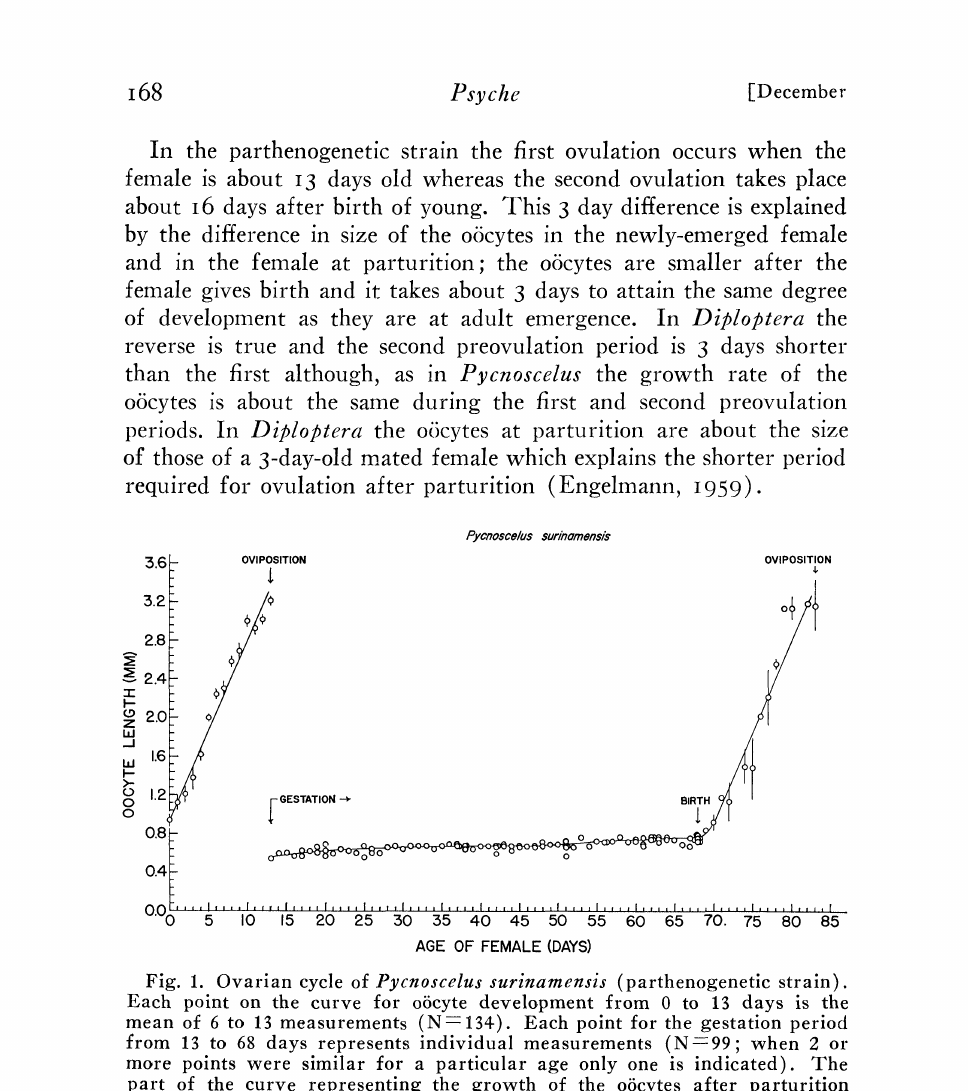
Fig. 1. Ovarian cycle of Pycnoscelus surinamensis (parthenogenetic strain). Each point on the curve for o6eyte development from 0 to 13 days is the mean of 6 to 13 measurements (N--134). Each point for the gestation period from 13 to 68 days represents individual measurements (N--99; when 2 or more points were similar for a particular age only one is indicated). The part of the curve representing the growth of the o6cytes after parturition (birth) is based on to individuals (N--24) for each point. Vertical bars =standard errors of mean